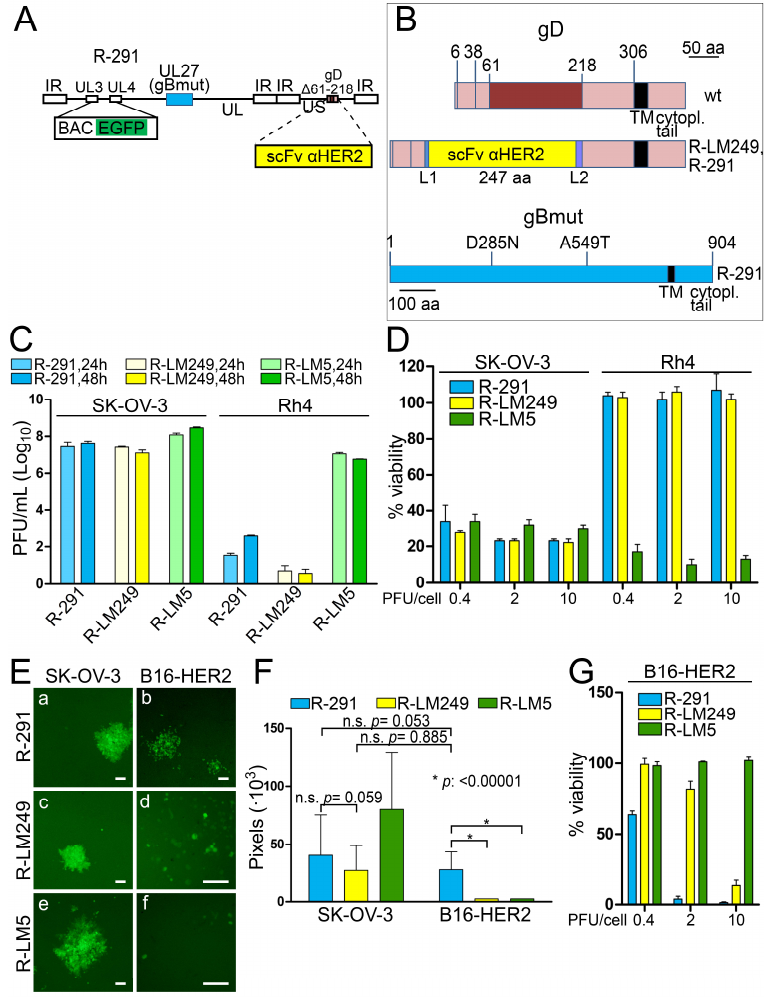
Figure 6. Effect of mutations in gB on virus replication and spread in human and murine cells. ( A ) Schematic drawing of the R-291 genome. The scFv to HER2 is inserted in place of aa 61–218 of gD. pBeloBAC11 and EGFP (BAC EGFP) are inserted between UL3 and UL4 [50]. UL27, encoding gB, is shown as a light blue box. gBmut carries the mutations D285N and A549T, as detailed in panel B. ( B ) Schematic diagram of wt gD (upper line), of R-LM249 and R-291 gD (middle line), and of R-291 gB (bottom line) carrying the mutations D285N and A549T (gBmut). ( C ) Replication of R-291, R-LM249, and R-LM5 recombinants in human HER2-positive (SK-OV-3) or HER2-negative (Rh4) tumor cell lines, infected at 1 PFU/cell, and harvested at 24 and 48 h after infection. The plotted values represent the average of two independent experiments ± SD. ( D ) Effect of virus infection on cell viability. The human HER2-positive (SK-OV-3) or HER2-negative (Rh4) tumor cell lines were infected at the indicated MOI and cell viability was assessed at day 4. The bars represent the averages of at least three replicate samples ± SD. ( E ) Examples of typical plaques by R-291, R-LM249, and R-LM5 in the B16 murine cell line expressing HER2 (B16-HER2), and in SK-OV-3 cells. The levels, brightness, and contrast of the panels were adjusted by means of Adobe Photoshop as follows: (a): input level (black) 30, brightness +50, contrast +50; (b): brightness +50, contrast +80, input level (black) 50; (c) input level (black) 30, brightness +50, contrast +50; (d): input level (black) 30, brightness +50, contrast +50; (e) input level (black) 30, brightness +50, contrast +50; (f) input level (black) 30, brightness +100, contrast +50. Scale bar = 100 µ m. ( F ) Average sizes of plaques made by the indicated viruses in B16-HER2, and in the human SK-OV-3 cells, for comparison. The bars represent the average pixel counts for 35 plaques ± SD, in pictures taken with a 4 × objective. *: statistically significant; n.s.: not significant. ( G ) Effect of virus infection on B16-HER2 viability. Cells were infected at the indicated MOI and cell viability was assessed at day 4. The bars represent the averages of four replicate samples ±